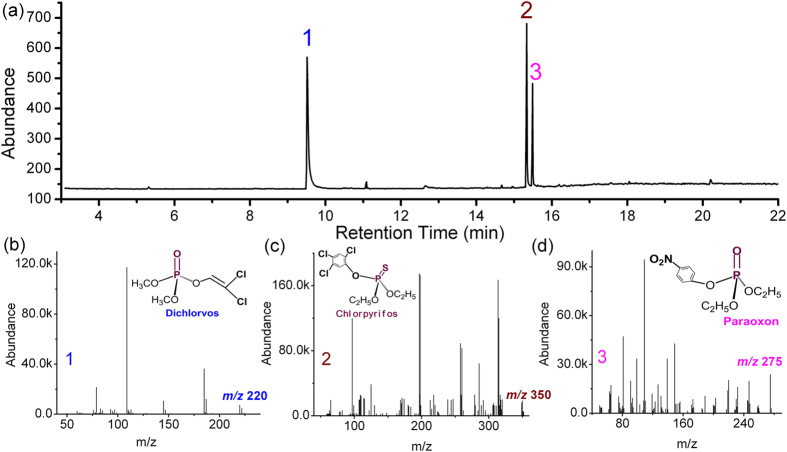
GC-MS analysis for the extracted ethanol solution, which contains three kinds of organophosphorous pesticides of dichlorvos, paraoxon and chlorpyrifos.(a) GC-MS obtained total ion current chromatogram of the extract. (b–d) Mass spectra for the compounds of 1, 2 and 3 in Fig. 4a, respectively. According to the identified results with the NIST08 mass spectral library, the compounds of 1, 2 and 3 are clearly assigned to dichlorvos, chlorpyrifos and paraoxon, respectively.